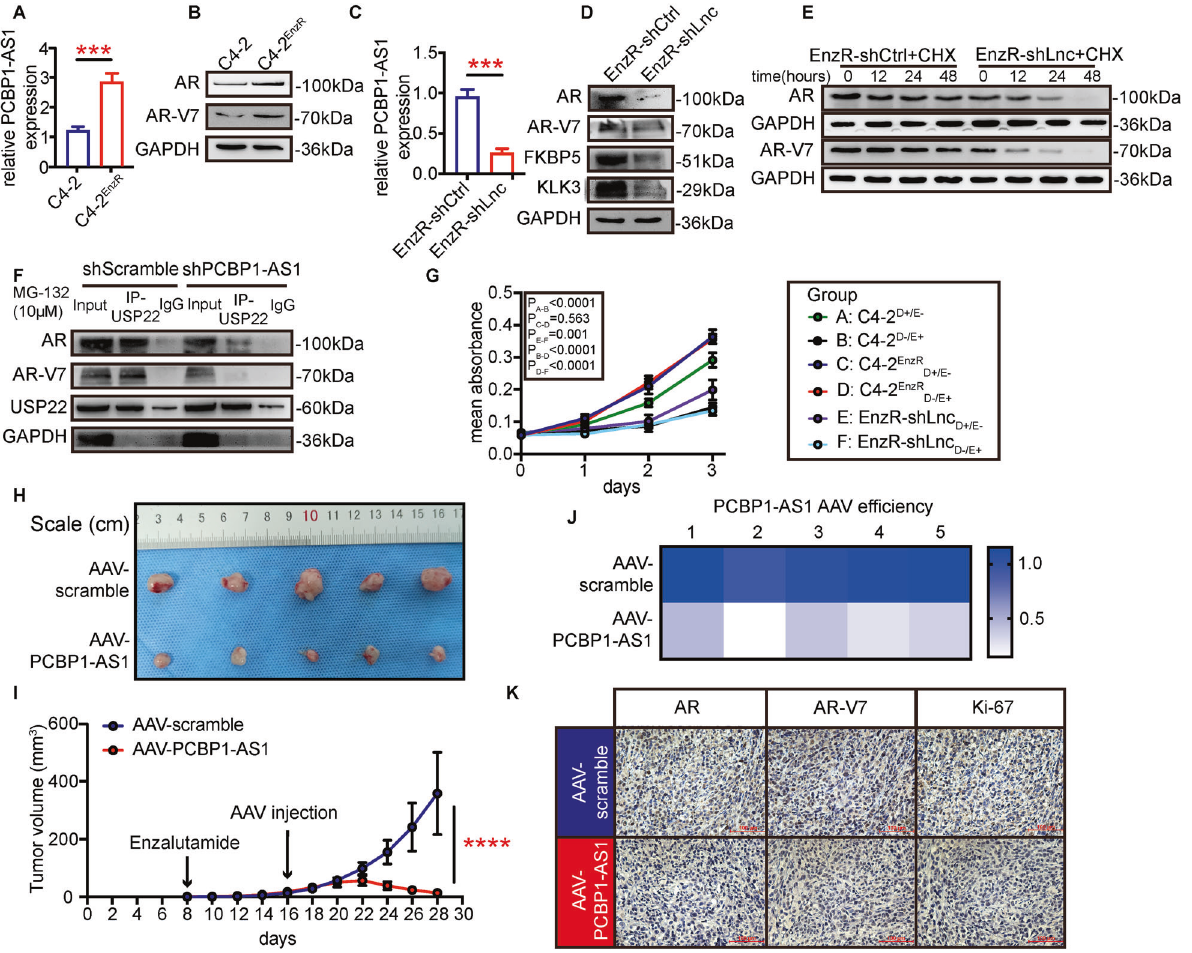
Fig. 5 Targeting PCBP1-AS1 repress USP22-AR-V7 stability and CRPC enzalutamide resistance. A PCBP1-AS1 expression in C4-2 and C4-2- EnzR cells. B AR, AR-V7 expression in C4-2 and C4-2-EnzR cells. C PCBP1-AS1 knockdown ef fi ciency in C4-2-EnzR cells. D AR, AR-V7, KLK3, FKBP5 expression before and after PCBP1-AS1 knockdown. E AR, AR-V7 degradation rate after CHX addition in indicated groups. F AR-USP22, AR-V7-USP22 binding ability detection using the co-IP assay. G Cell viability detected by MTT in indicated groups. H Enzalutamide-resistant tumors of the in vivo experiments. I Tumor growth rate of indicated groups. J PCBP1-AS1 expression detected by qPCR, present by heatmap. K AR, AR-V7, and Ki-67 expression in indicated groups, presented by IHC. Panels A – G were repeated three times, panels H – K were repeated two times, with fi ve biological replicates each time. Signi fi cance: * P <0.05, ** P <0.01, *** P <0.001, **** P